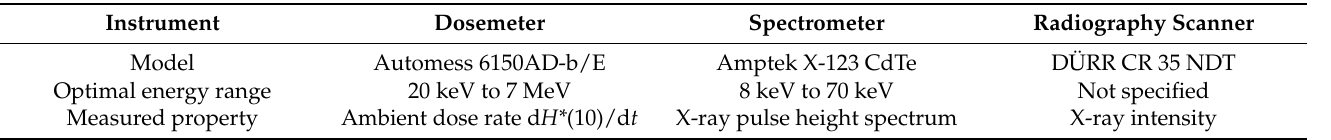
Table 2. Overview and description of the measurement instruments. The optimal energy range of the Automess 6150 doseme- ter lies above 20 keV. However, it is calibrated in an ISO radiation quality N-15 reference field at PTB.